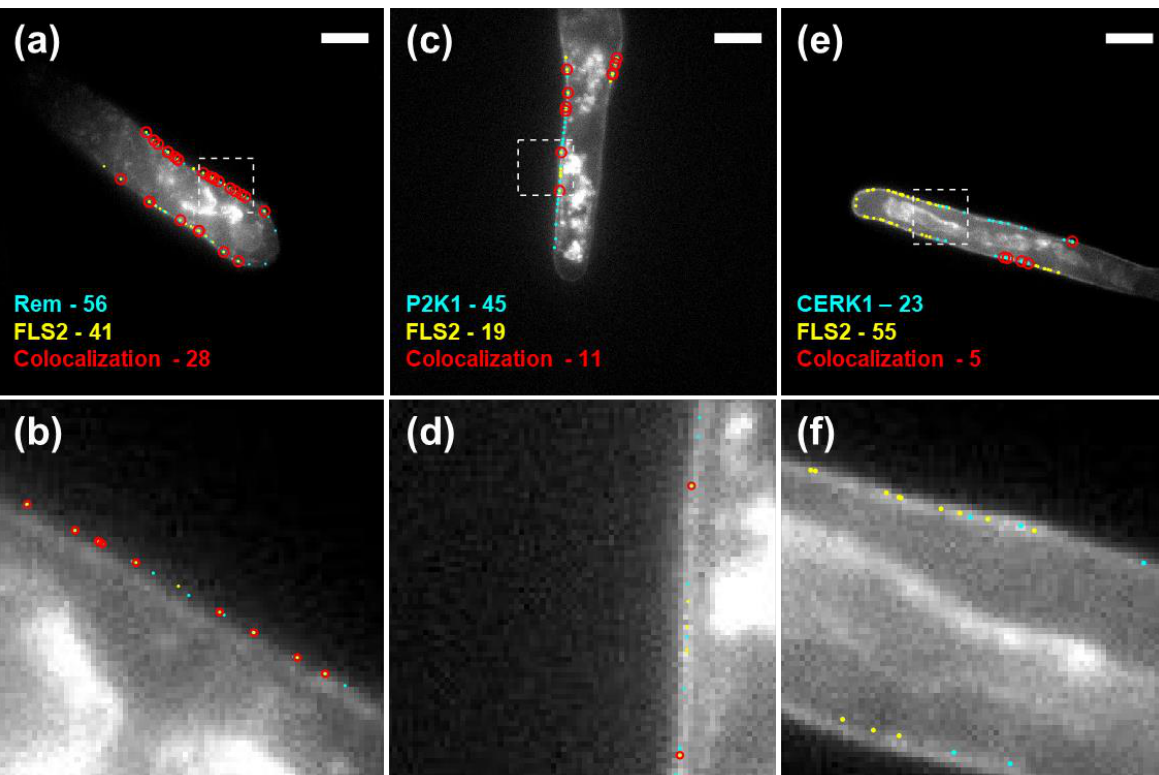
Figure 4. Example of super-resolution images of Arabidopsis thaliana root hairs, detailing images of remorin/FLS2 ( a , b ), P2K1/FLS2 ( c , d ), and FLS2/CERK1 ( e , f ). The areas marked by the squares in ( a , c , e ) are enlarged in ( b , d , f ), respectively. For ( b , d ), red circles are 100 nm radius, depicting the colocalization range. No colocalization within 100 nm is found in ( f ). Scale bars are 10 µm.